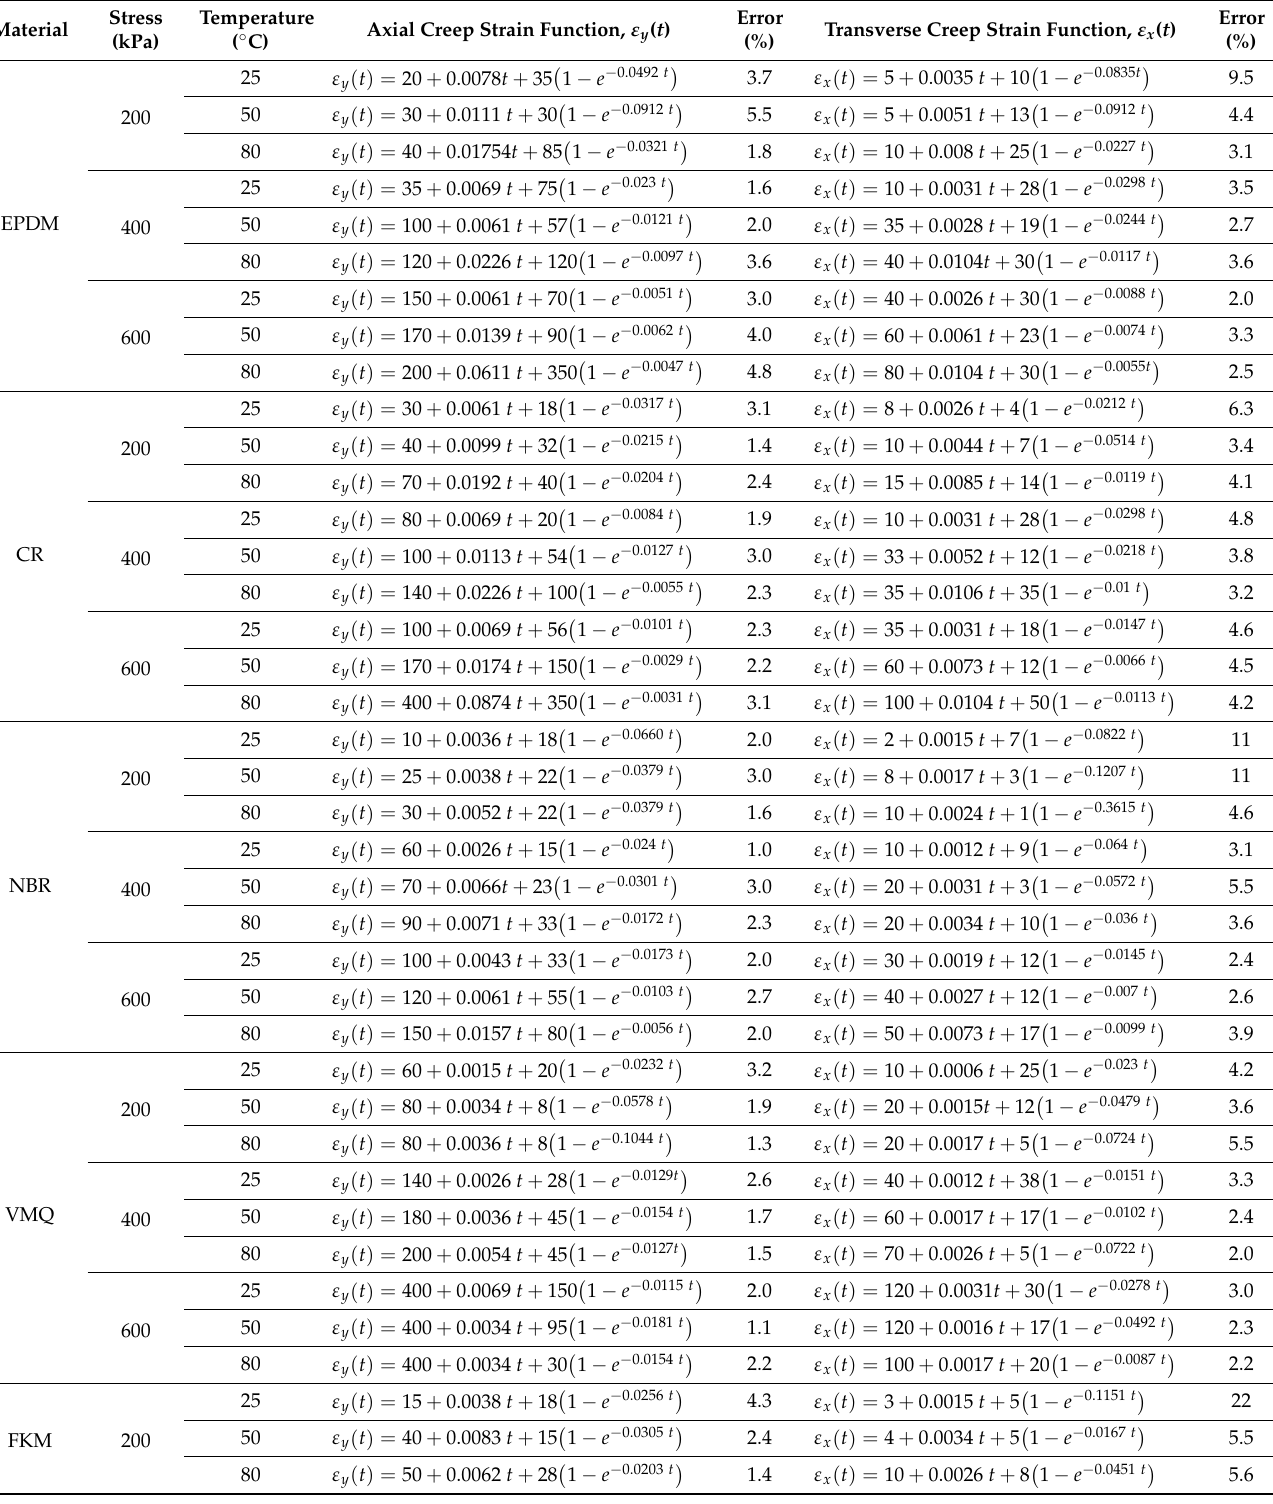
Table 2. Axial and transverse creep strain functions for the elastomers and conditions